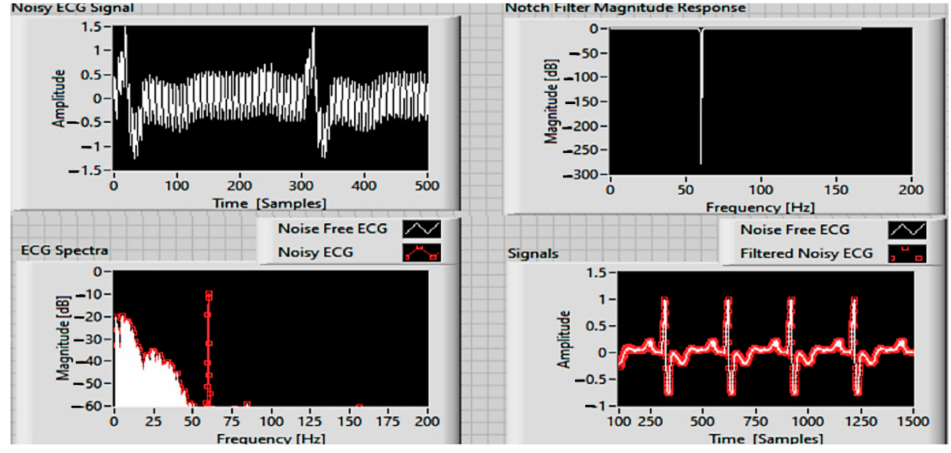
Figure 13. ECG signal filtering results in the 0–35 Hz band of